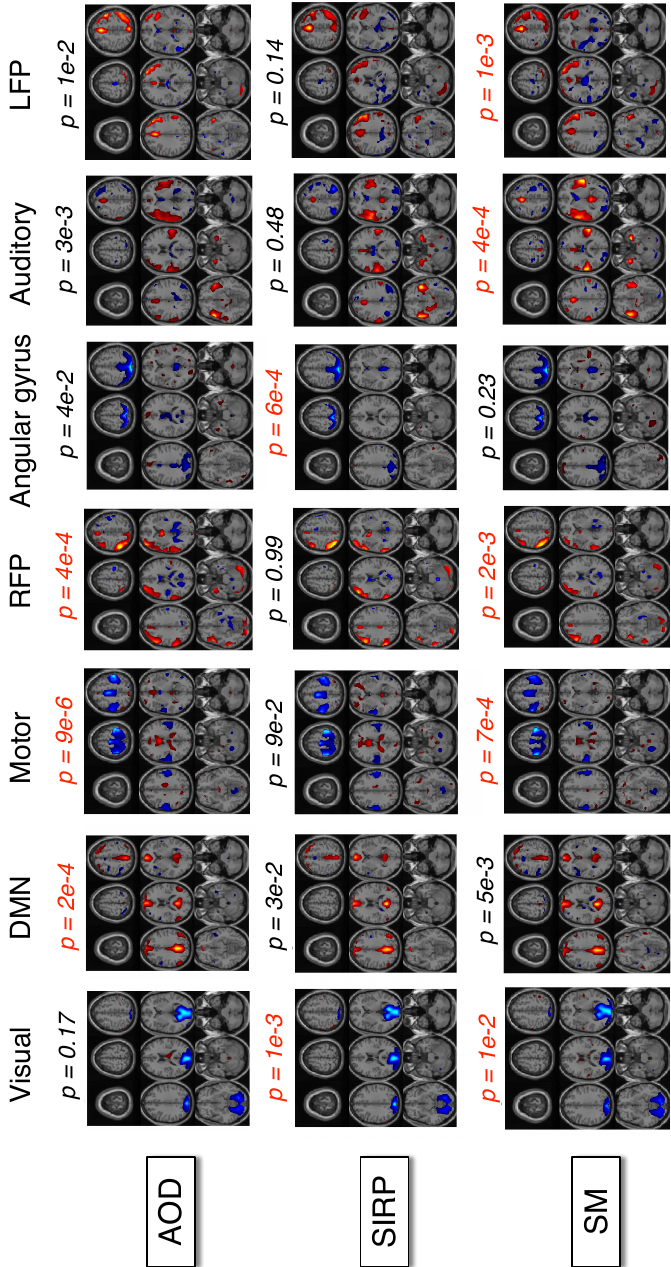
Figure 7. FMRI components estimated by the IVA-L-SOS algorithm. Here, the colormap of the components is adjusted so that the colors red, orange and yellow mean higher relative activation in controls and blue means higher relative activation in patients. The estimated components show significant group differences even after strict Bonferroni correction ( ( p × 25 ) ≤ 0.05) in DMN, FP, motor, and auditory cortex areas for AOD and SM tasks; and visual cortex and AG areas for the SIRP